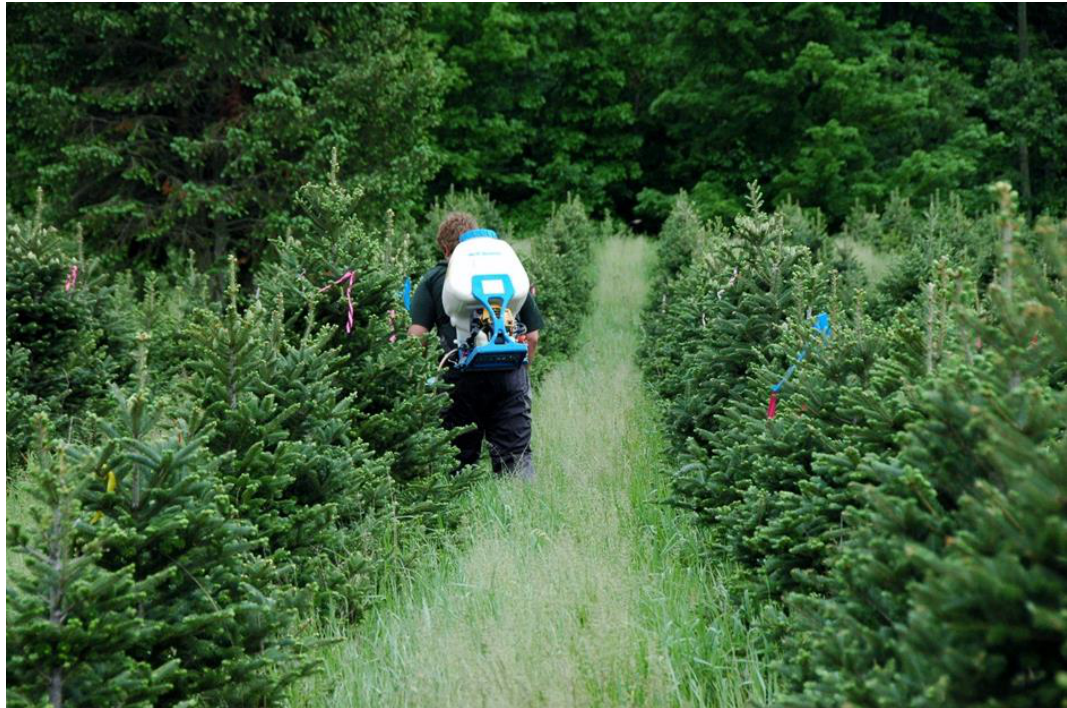
Figure 2. Paclobutrazol is soil-injected in a Fraser fir plantation using a back-pack injection system.